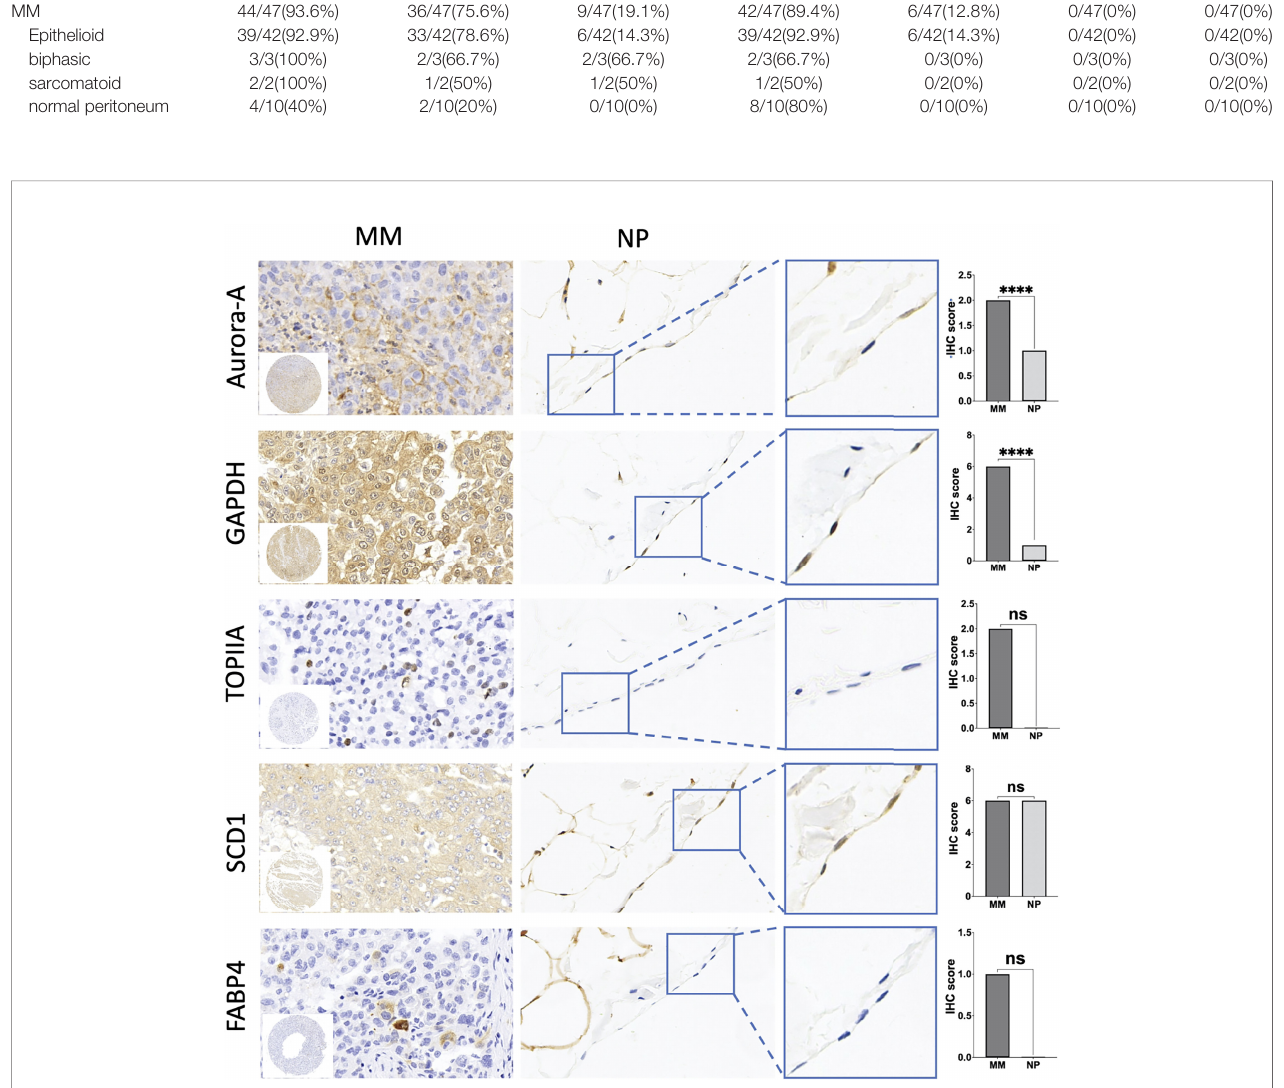
FIGURE 5 | Immunohistochemical (IHC) staining of tissue microarrays (TMA) of malignant mesothelioma (MM) and normal peritoneal (NP) samples to identify the expression of hub genes. Ampli fi cation of IHC images of representative mesothelial cells in NP tissue was shown in the blue box. Signi fi cant differences are shown in Aurora-A and GAPDH. Quanti fi cation of IHC results of aforementioned key genes is shown in the box plot. **** p < 0.0001; ns, not statistically signi fi